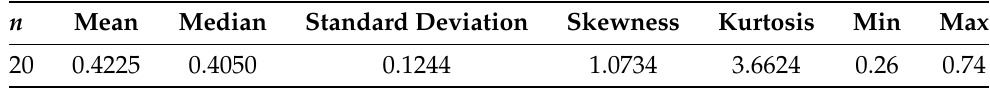
Table 10. Statistical summary for the flood level data set.